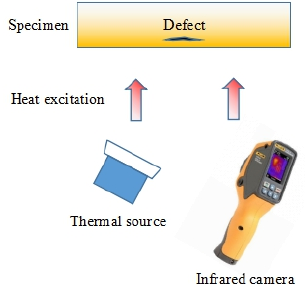
Figure 1. Schematic diagram of infrared thermography detection.